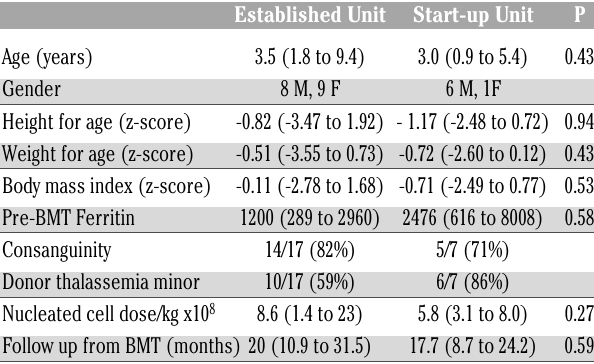
Table 1. Characteristics of patients treated at the established insti- tution (NIBD) versus a start up service (PIMS).